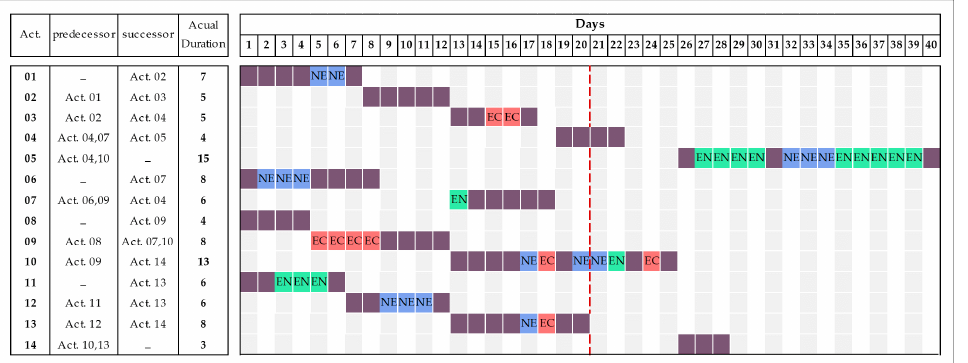
Figure 4. As-built schedule.